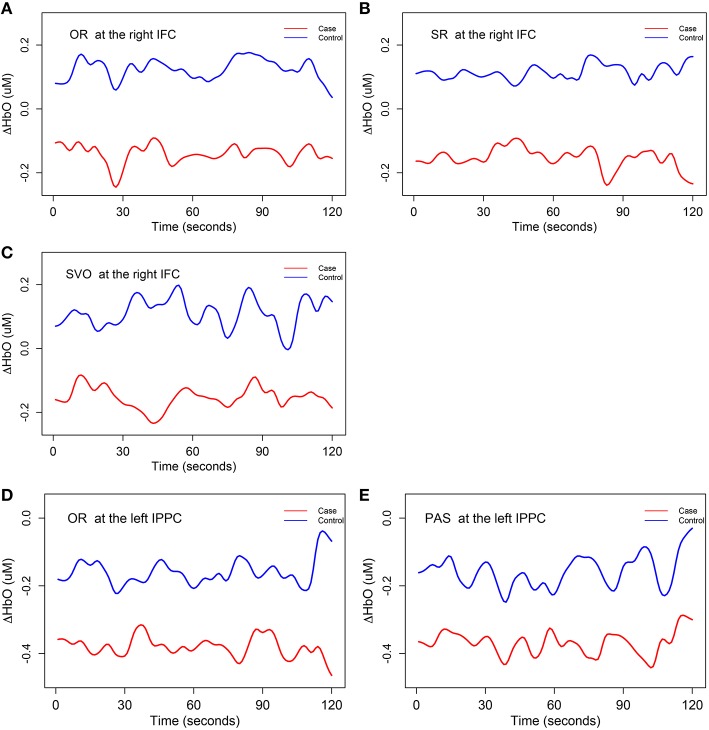
The mean trends for ΔHbO (i.e., H01). The mean trajectories μ^c(t) of 15 smoothing ΔHbO curves, in the control group are depicted as a blue line and similar information for case group are depicted as a red line. IFC, inferior frontal cortex; IPPC, inferior posterior parietal cortex. OR, object relative clause sentences; SR, subject relative clause sentences; SVO, subject-verb-object sentences; and PAS, passive sentences. (A) The mean trajectories of ΔHbO for OR syntax type at the right IFC; (B) the mean trajectories of ΔHbO for SR syntax type at the right IFC; (C) the mean trajectories of ΔHbO for SVO syntax type at the right IFC; (D) the mean trajectories of ΔHbO for OR syntax type at the left IPPC; (E) the mean trajectories of ΔHbO for PAS syntax type at the left IPPC.